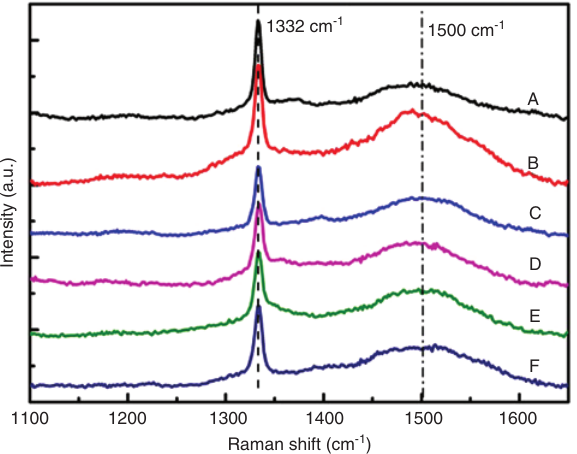
Figure 7: FWHM of diamond film samples at various gas flow rates -1, (sccm). (A) O -0, Ar-0; (B) O -0, Ar-15; (C) O 2 2 2 (E) O -3, Ar-12; (F) O -4, 2 2